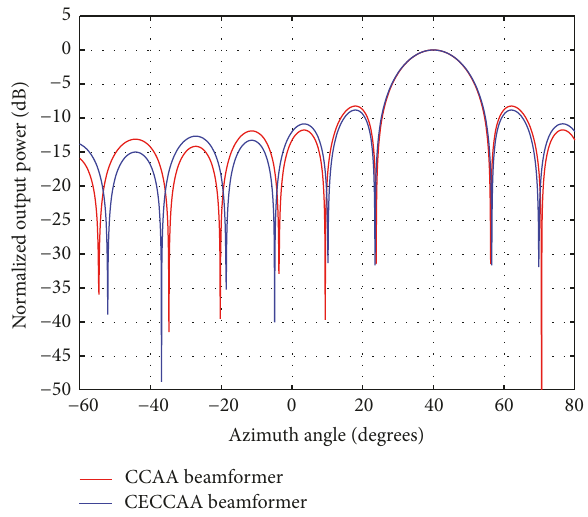
Figure 3: Directivity pattern comparison between the CCAA beamformer and CECCAA beamformer.